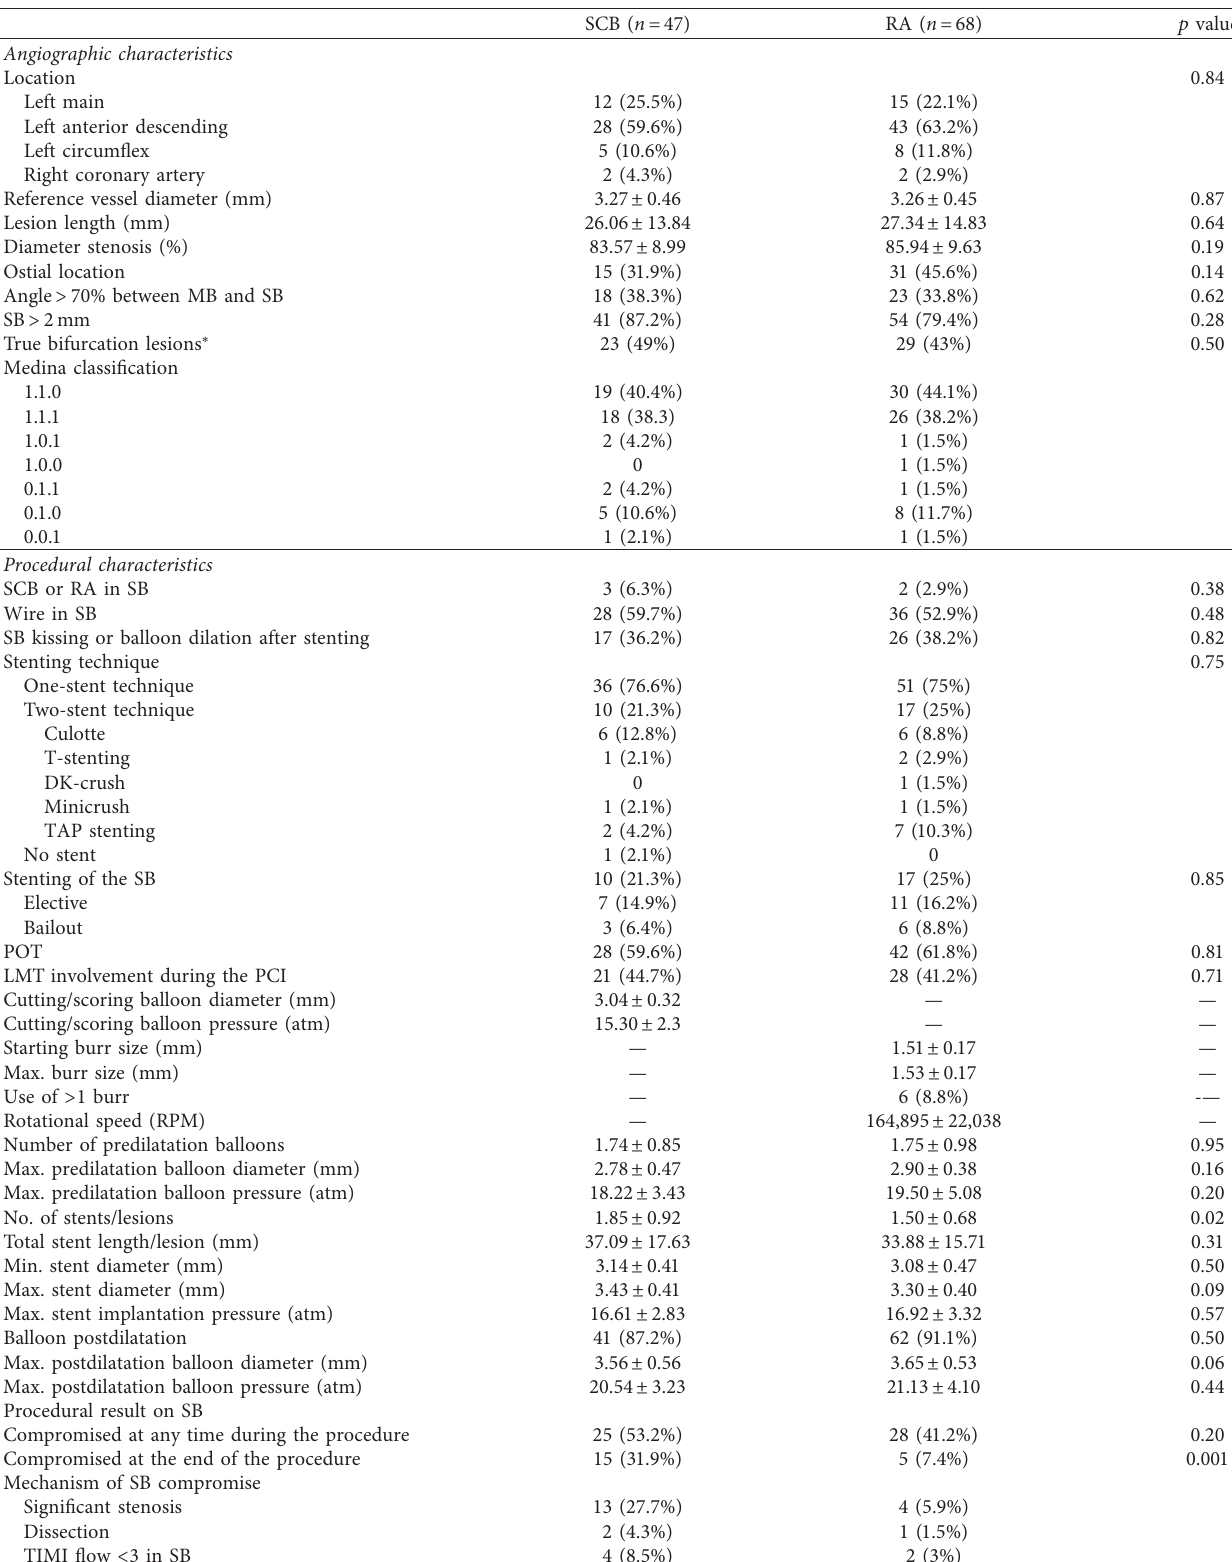
Table 2: Angiographic and procedural characteristics ( n � 115